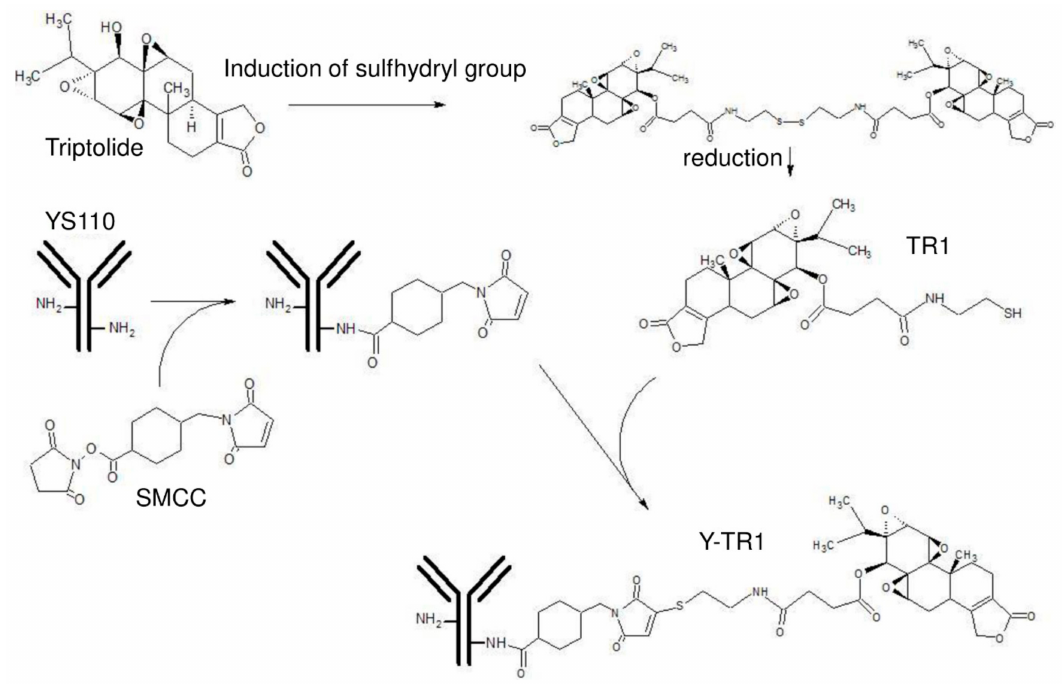
Figure 1. Structural formula of triptolide and conjugation protocol of Y-TR1 (SMCC). Triptolide was modified by a sulfhydryl (SH) group and was provided as an S-S dimer for chemical stability. The SH group-induced triptolide was designated TR1. The S-S bond was reduced to the SH monomer by the tris(2-carboxyethyl) phosphine (TCEP) reducing gel just before reaction. The humanized anti-CD26 monoclonal antibody YS110 was modified by the heterobifunctional linker SMCC. SMCC-modified YS110 and TR1 monomers were mixed and allowed to react overnight and purified. See Methods for